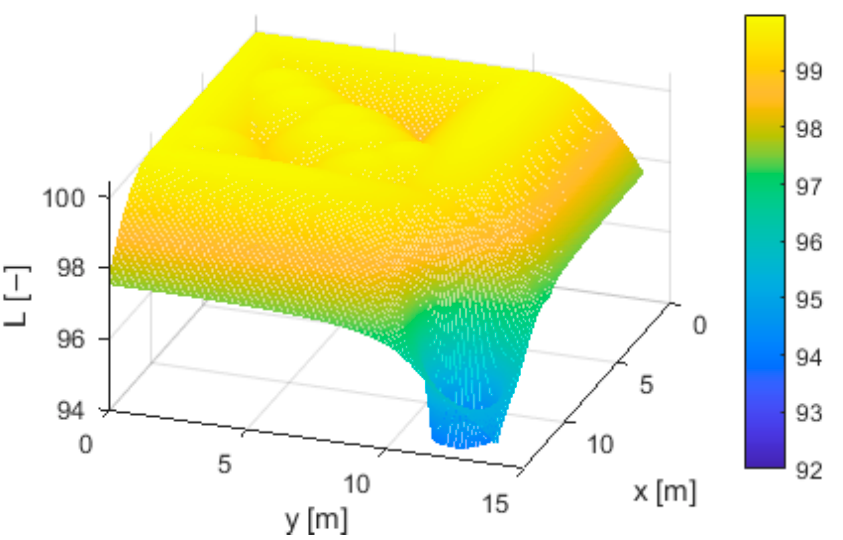
Figure 11. Enlargement of the region of interest of the results of the Lyapunov function 𝐿 in the whole navigation area for Agent K.